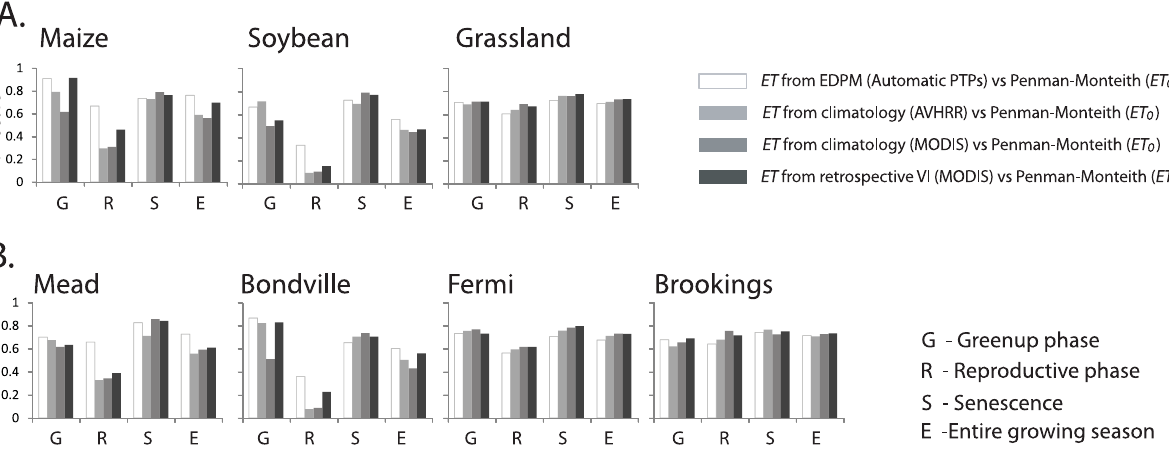
Fig. A2. Temporal details of Penman-Monteith model performance relative to the VegET with different phenological forcings revealed by F -scores. Results arranged (A) by vegetation/crop type and (B) by